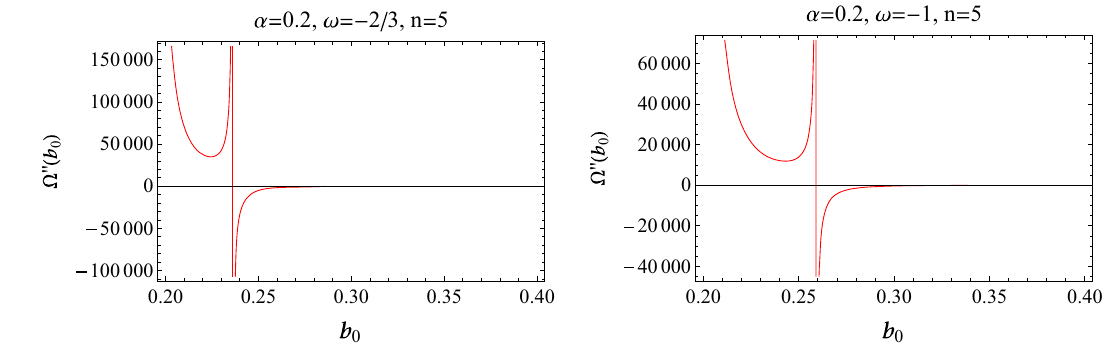
Fig. 7 Stable and unstable behavior of thin-shell gravastars for generalized phantomlike EoS with different values of ω